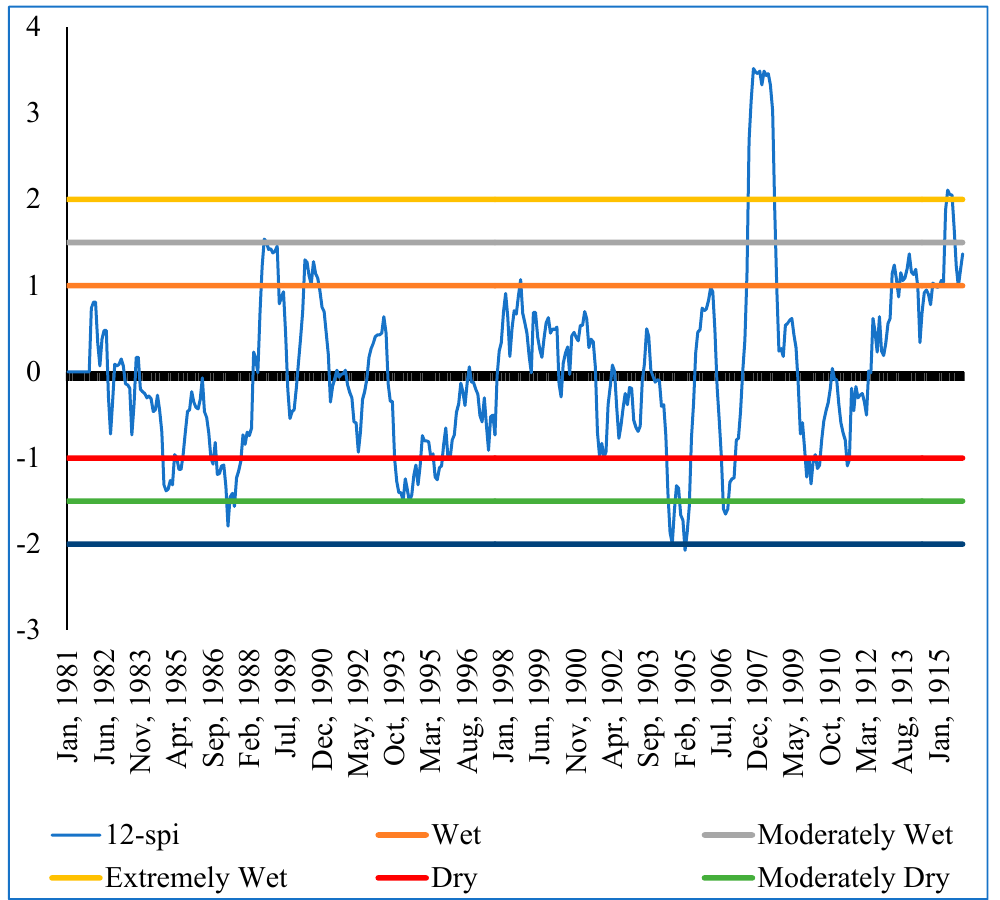
Figure 7. Twelve-month SPI over Sipi sub-catchment (1981–2015).